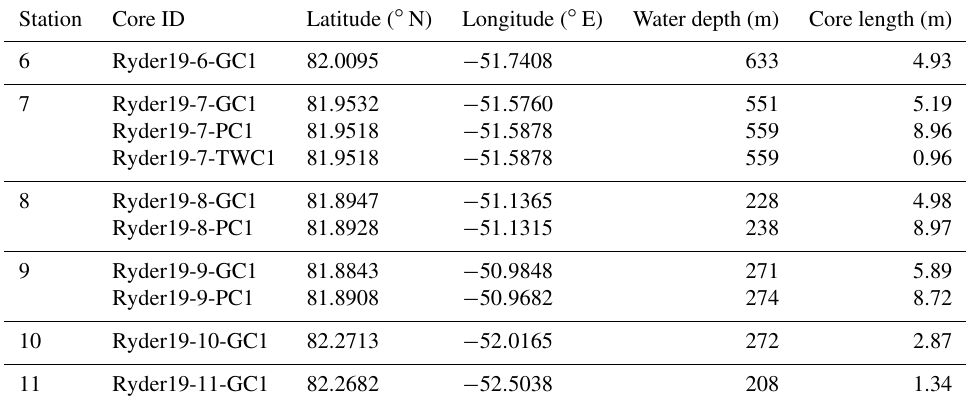
Table 2. Locations, water depths, and lengths of cores used in this study. Station Core ID Latitude ( ◦ N) Longitude ( ◦